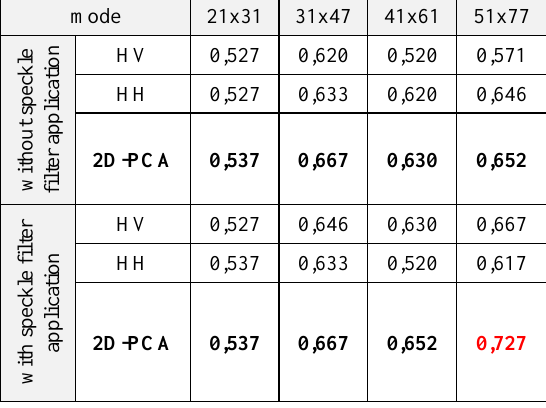
Table 2 FoM calculation for Envisat